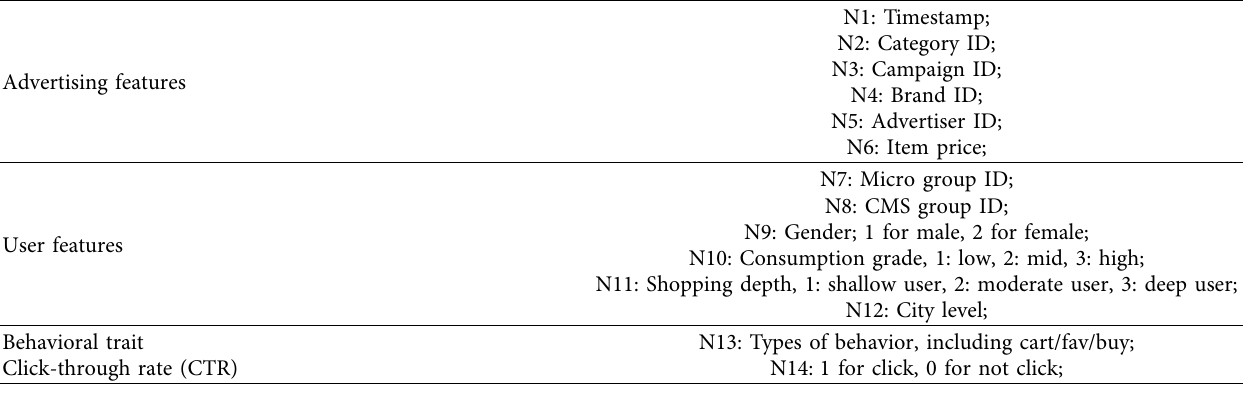
Table 2: The dataset’s selected features (Instagram).